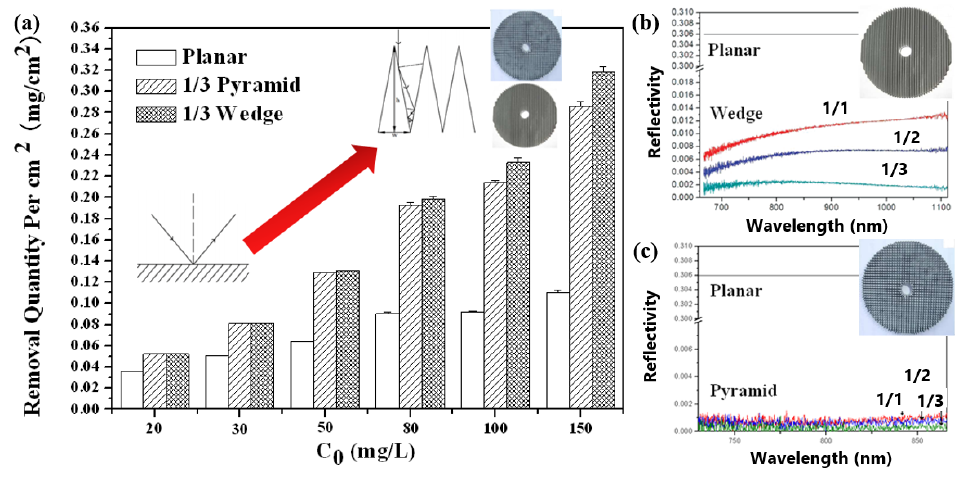
Figure 5. ( a ) Absolute quantity per m 2 of RhB removal for 1 h obtained by planar structured, wedge structured, and pyramid structured photoanode and light reflectivity obtained by ( b ) wedge structured photoanode and ( c ) pyramid structured photoanode, with different bottom-to-height ratio. Reprinted/adapted with permission from Ref. [64]. 2011, American Chemical Society.